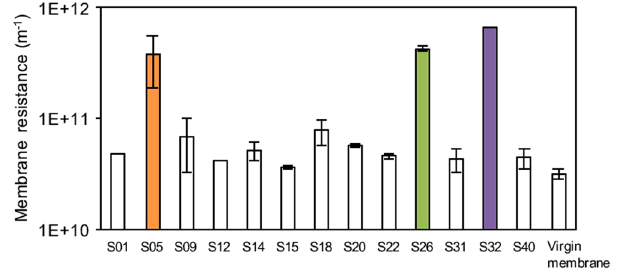
Figure 1. Fouling potential of 13 isolated strains (see Table 1) cultivated as single-cultures and virgin membrane. Since S05, S26, and S32 exhibited high fouling potential, they were regarded as fouling-causing bacteria (FCB) in this study. The error bars indicate the standard deviations of two independent